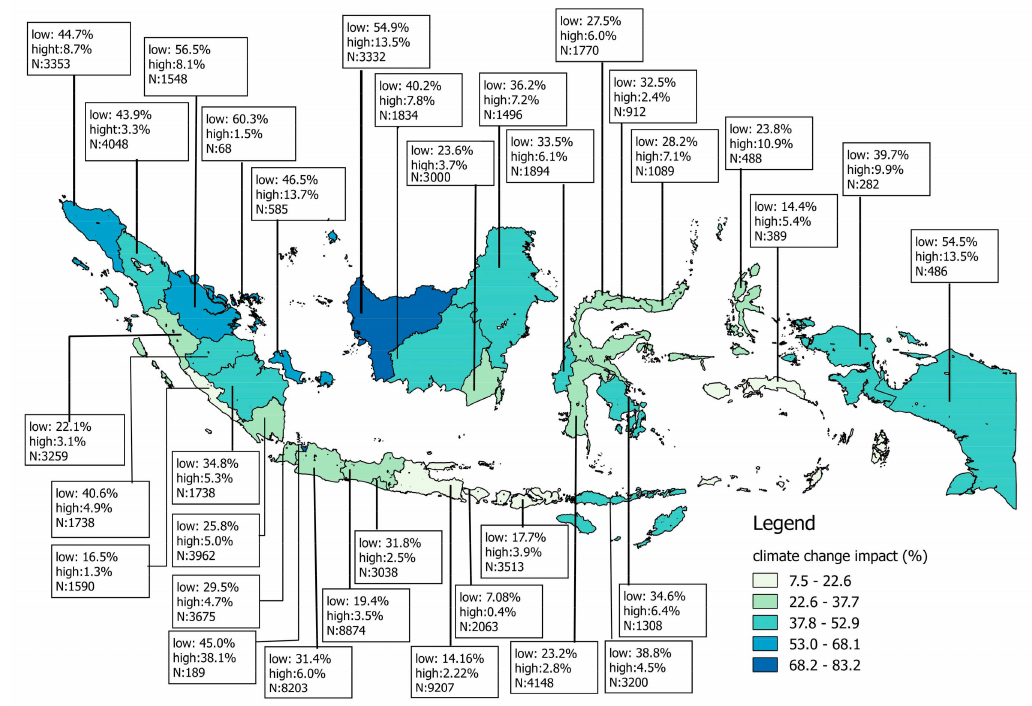
Figure 2. The distribution of the sample and the percentage of farmers who experienced e ff ects of climate change (CC) for each province in